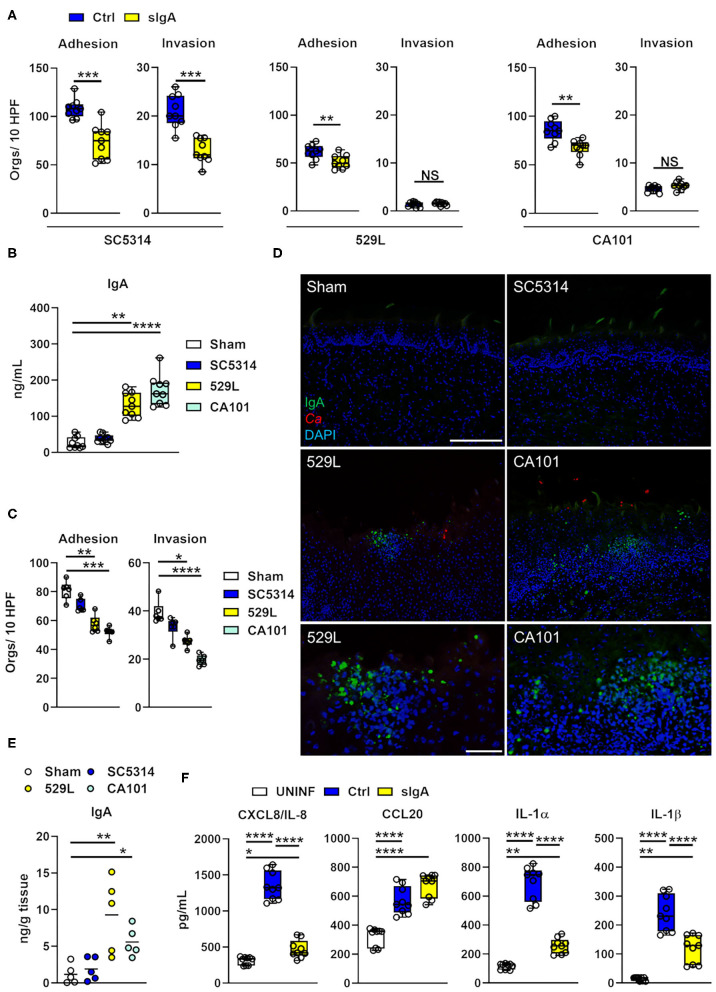
Oral fungal colonization upregulates mucosal IgA preventing C. albicans epithelial adhesion and invasion. (A) Indicated C. albicans strains were incubated with sIgA prior to infection of the OKF6/TERT-2 oral epithelial cell line. The cells were infected for 2.5 h, after which the number of adhered and invaded organisms was determined using a differential fluorescence assay. Box Whisker plot shows three experiments, each performed in triplicate. Orgs/10 HPF, organisms per 10 high-power fields; Ctrl, control. Statistical significance was determined using Mann-Whitney test (*P < 0.05; **P < 0.01). (B) Total IgA amounts in saliva (diluted 1:10) determined by ELISA. Saliva was collected after 11 days of infection with indicated C. albicans strains. Three independent experiments performed in triplicate. **P < 0.01; ****P < 0.0001 (Kruskal-Wallis). (C) Indicated C. albicans strain was incubated with saliva of infected with prior infection of the murine keratinocyte cell line. The cells were infected for 2.5 h, after which the number of adhered and invaded organisms was determined using a differential fluorescence assay. Box Whisker plot shows three experiments, each performed in dublicate. Orgs/10 HPF, organisms per 10 high-power fields. Statistical significance was determined using Kruskal-Wallis test (*P < 0.05; **P < 0.01; ***P < 0.001; ****P < 0.0001). (D) Immunofluorescence of IgA in tongues 11 days post oral infection with indicated strains. IgA is shown in green, and C. albicans (Ca) in red. DAPI (blue) visualizes the tissue. Upper, middle panel scale bar 200 μm. Lower panel scale bar 50 μm. (E) Total IgA amounts in tongue homogenates determined by ELISA. Tongues were collected after 11 days of infection with indicated C. albicans strains; N = 5. *P < 0.05; **P < 0.01 (Kruskal-Wallis). (F) Indicated C. albicans strains were incubated with sIgA prior to infection of the OKF6/TERT-2 oral epithelial cell line. The cells were infected for 8 h after which CXCL8/IL-8, CCL20, and IL-1α/β were determined in the supernatant. Box Whisker plot shows three experiments triplicate. Uninf; uninfected; Ctrl, control. Statistical significance was determined using Kruskal-Wallis (*P < 0.05; **P < 0.01; ****P < 0.0001).